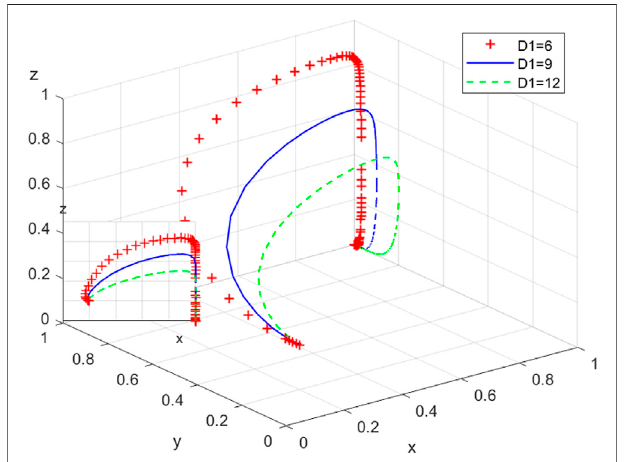
FIGURE 8 | Impact of long-term additional bene fi ts on the evolution track of the tripartite game when MEs govern actively.